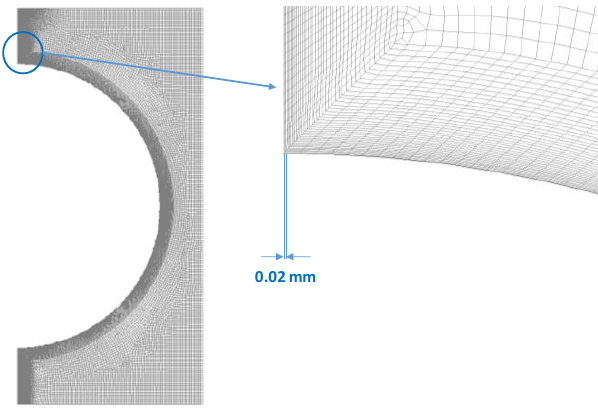
Figure 2. Mesh with fine boundary layers for CFD analysis.